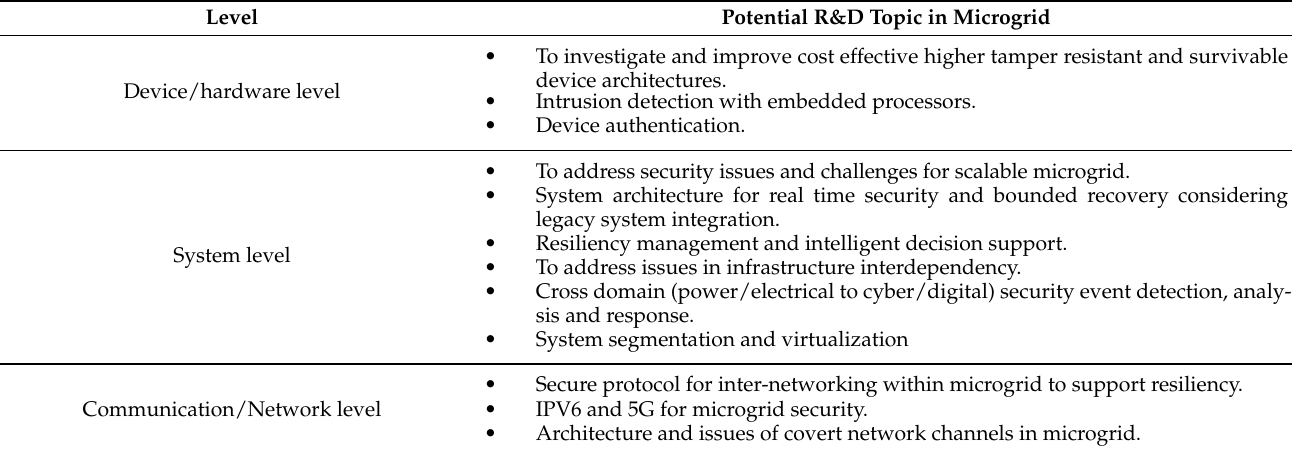
Table 4. Potential R&D topics in microgrid